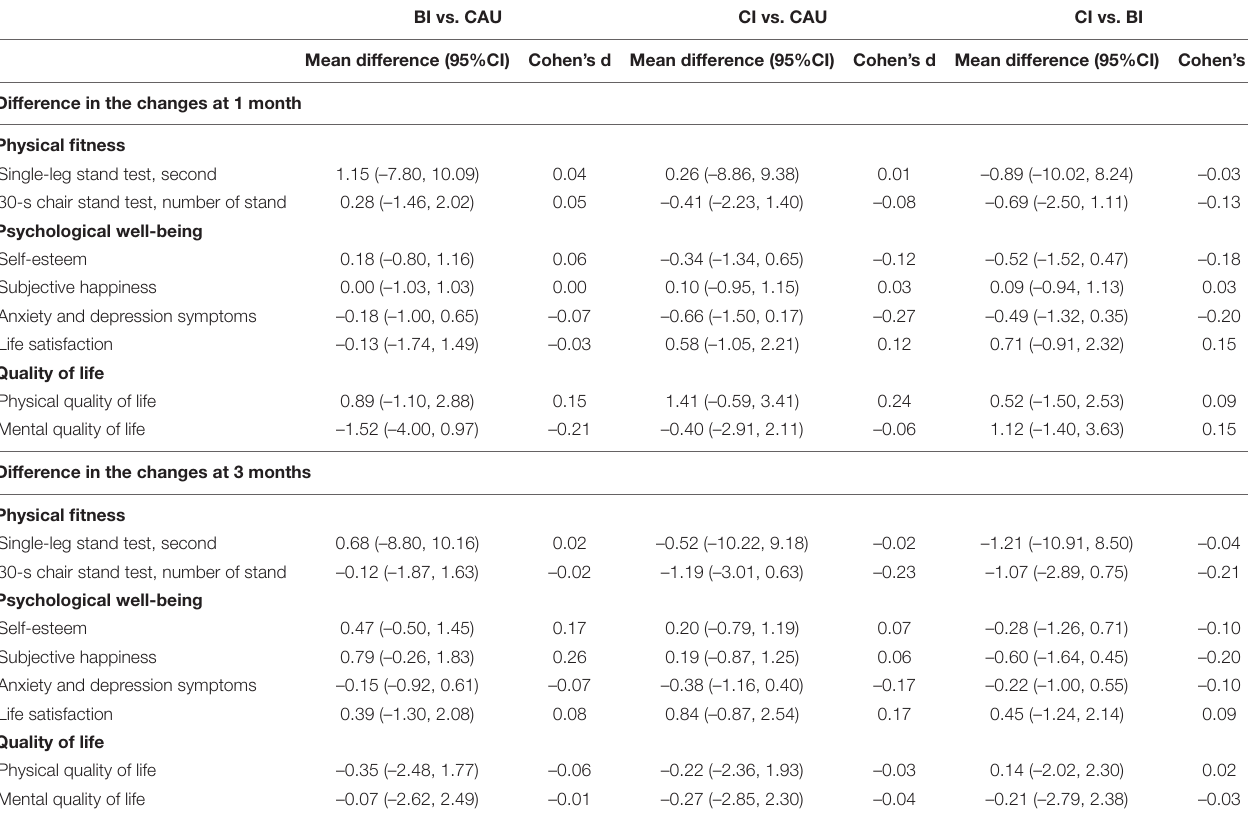
TABLE 4 | The between-group difference in the changes in physical fitness, psychological well-being, and quality of life at 1- and 3-month follow-up in three groups: Intention-to-treat analysis. BI vs. CAU CI vs. CAU CI vs.